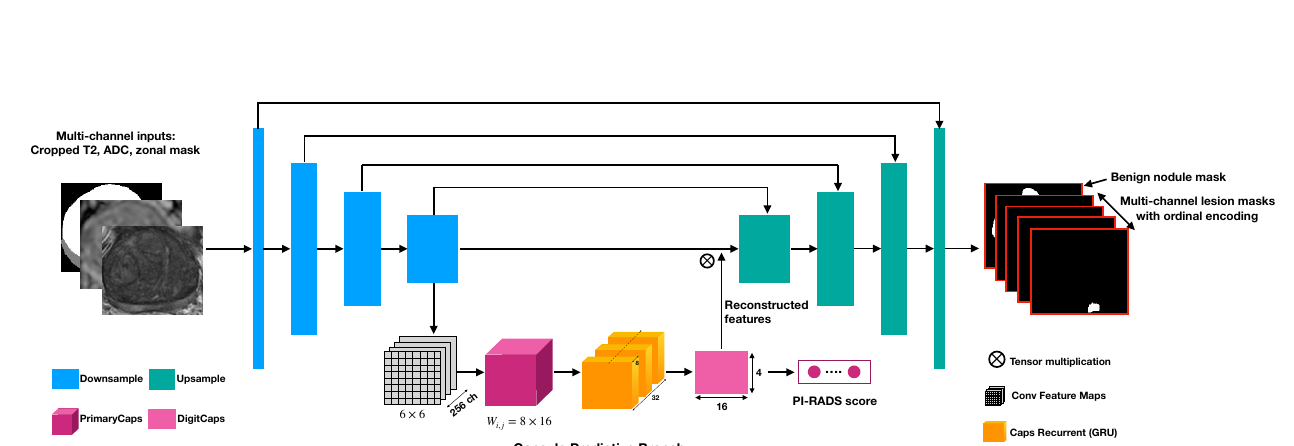
Figure 2. Architecture of the proposed MiniSegCaps, consisting of three parts: (1) MiniSeg, a lightweight segmentation network as the backbone for lesion mask prediction; (2) Capsule predictive branch for producing PI-RADS score; (3) CapsGRU module for exploiting spatial information across adjacent slices. The MiniSeg module extracts convolutional features maps from input mpMRIs and produces multi-channel masks for prostate cancer segmentation; learned features (6 × 6 × 256) by the last downsample block of MiniSeg are used as the inputs of capsule predictive branch for PI-RADS classification; with learned capsule feature stacks (8 × 32) by PrimaryCaps as inputs, the CapsGRU module exploits inter-slice spatial information during learning process; reconstructed features (6 × 6 × 256) by three fully connected layers [25] in the Capsule branch are also integrated into the MiniSeg module for better lesion